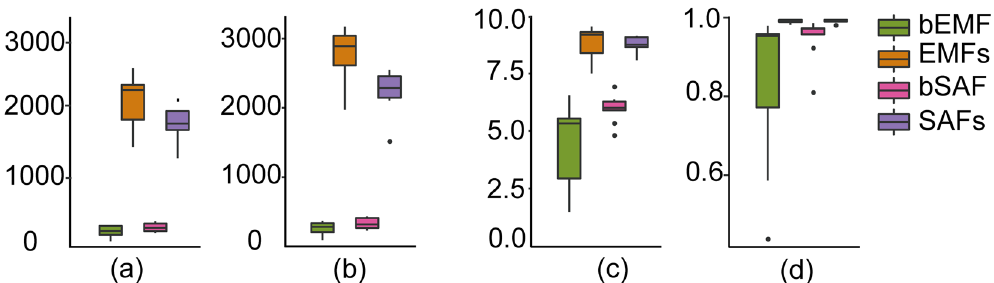
Figure 3. α -diversity indices of endophytic bacteria in two types of fruit bodies (bEMF and bSAF) and the bacterial in corresponding hyphosphere soils (EMFs and SAFs). ( a ) observed OTUs; ( b ) Chao1 index; ( c ) Shannon index; ( d ) Simpson